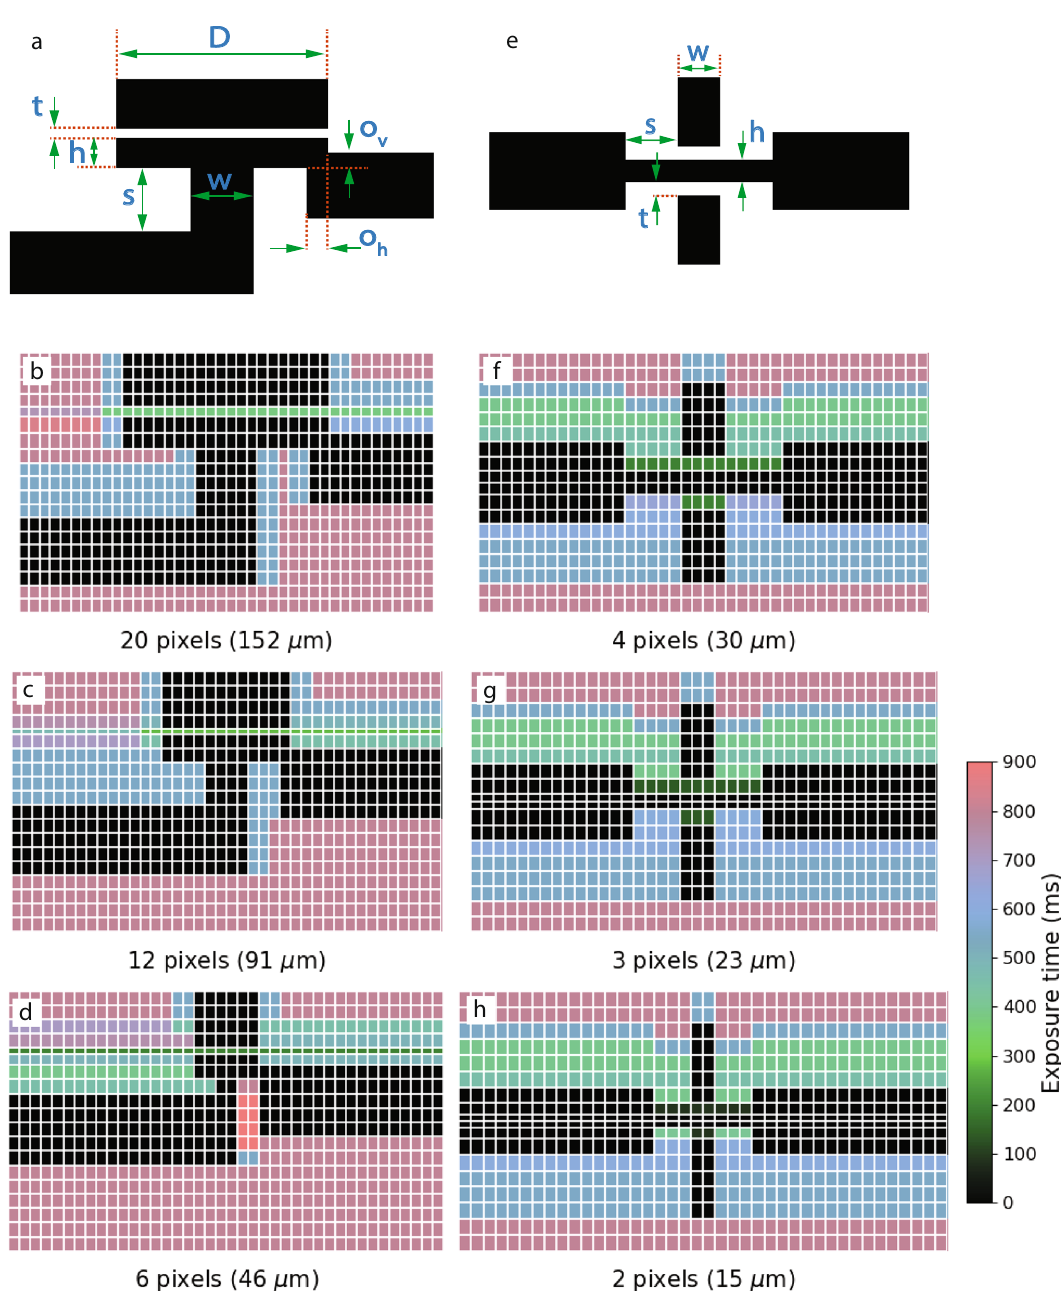
Fig. 2 Deliberate exposure time and layer thickness variation in 3D printing process. a Membrane valve designed dimension parameters, ( b – d ) membrane valve exposure times. e Squeeze valve designed dimension parameters, ( f – h ) squeeze valve exposure times. Tables 1 and 2 specify the variable layer thicknesses used for each type of